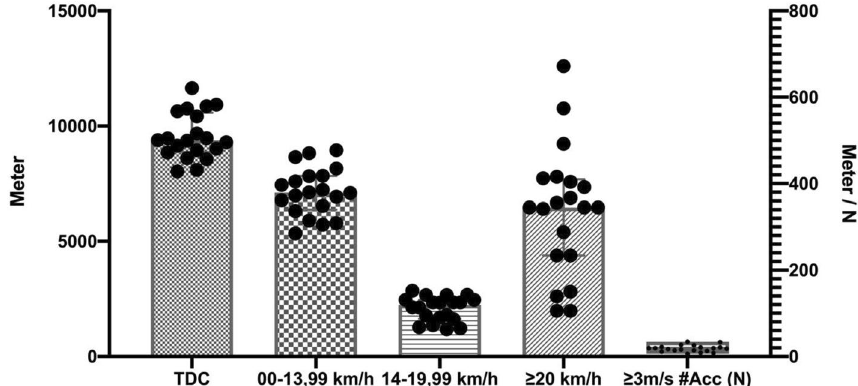
Figure 4. The total distance covered by all players in the match, over 00–13.99 km/h, 14–19.99 km/h and > 20 km/h (m) and ≥ 3 m/s #Acc (N).